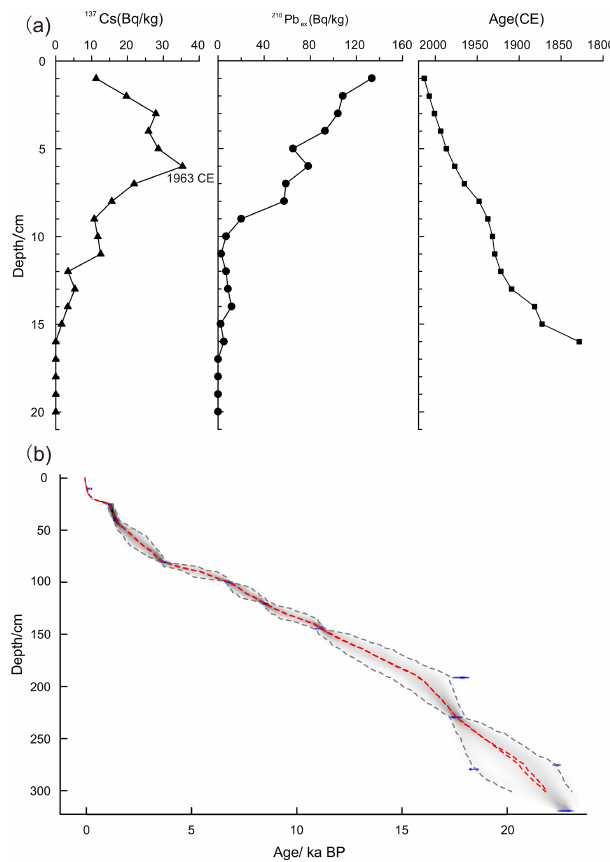
Figure 4. Age-depth model of the Gahai Lake sediment core de- rived from 137 Cs, 210 Pb, and 14 C dating. (a) Black line with tri- angles: 137 Cs age; black line with solid circles: 210 Pb : 210 Pb ex age; black line with squares: mean age based on annual lamination counting. (b) Age-depth curve based on a 210 Pb profile of recent sediments and 13 AMS radiocarbon dates from Gahai Lake. The range of the two dashed grey lines indicates the 95% confidence in- tervals, and the dashed red lines show the single “best” model based on the weighted mean age for each